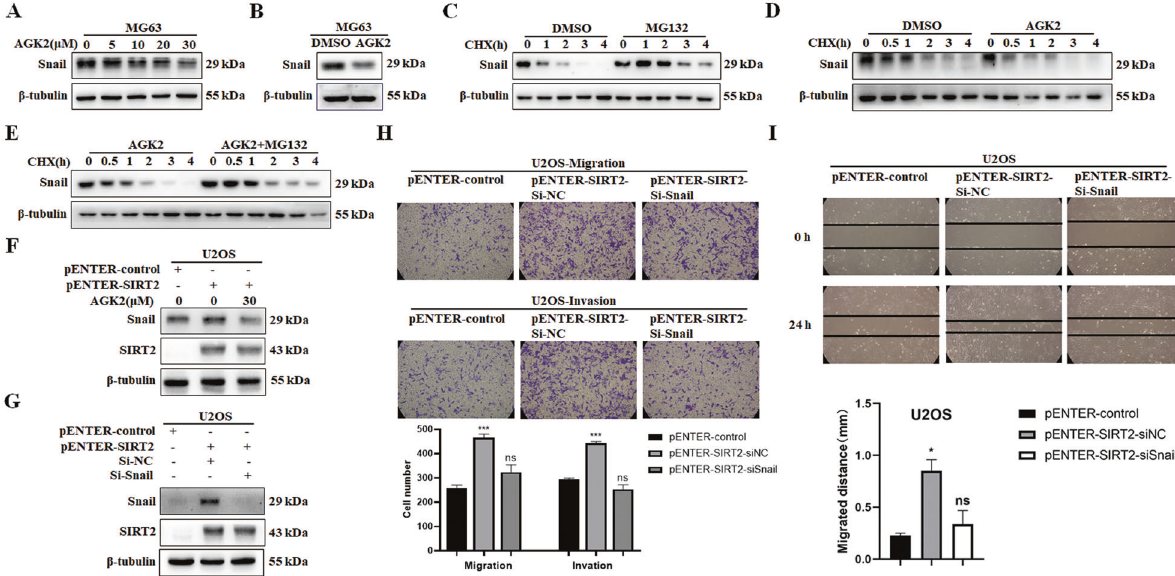
Fig. 8 Inhibition of SIRT2 activity downregulates Snail expression through the proteasomal degradation. A Treatment of MG63 cells with AGK2 showed a dose-dependent decrease in Snail expression. Data from a representative experiment of at least three independent samples are shown. B MG63 cells were treated with 30 μ M AGK2 to detect the expression of Snail protein. C CHX was used to inhibit the synthesis of protein, and MG132 was used to treat MG63 cells. Data from a representative experiment of at least three independent samples are shown. D CHX and AGK2 were used to treat MG63 cells. Data from a representative experiment of at least three independent samples are shown. E After the combined treatment with MG132 and AGK2, Snail expression was detected. Data from a representative experiment of at least three independent samples are shown. F SIRT2-overexpressing cells were treated with AGK2 and Snail levels were detected. Data from a representative experiment of at least three independent samples are shown. G SIRT2-overexpressing cells were transfected with Snail siRNA and Snail levels were detected. Data from a representative experiment of at least three independent samples are shown. H , I Transwell and wound-healing assay were used to analyze the effect of Snail knockdown on the migration and invasion of SIRT2-overexpressing cells.